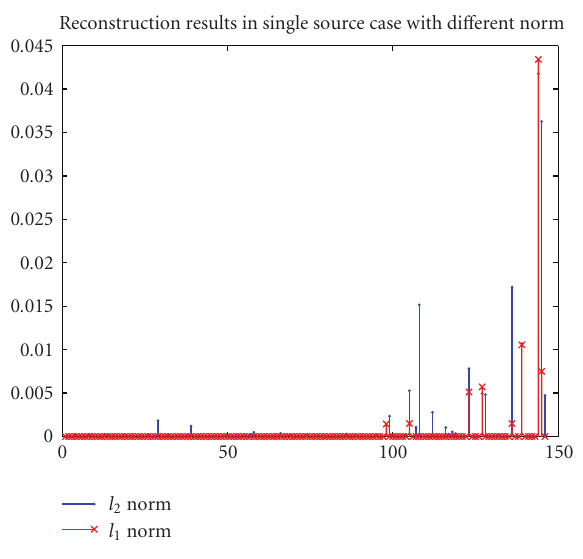
Figure 4: Comparison of the regularized solutions on the initial coarse